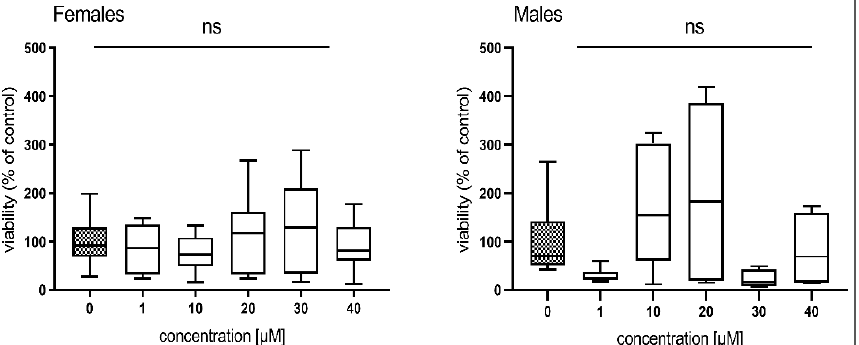
Figure 2. The effect of compound HBK4 on the viability of H. contortus adults of the ISE strain after incubation (48 h). The data are expressed in percentage of viability of the controls (=100%) and presented as a box plot ( n = 12). For statistical analysis, one-way ANOVA with Dunnett’s multiple comparison test was used. ns, p > 0.05.